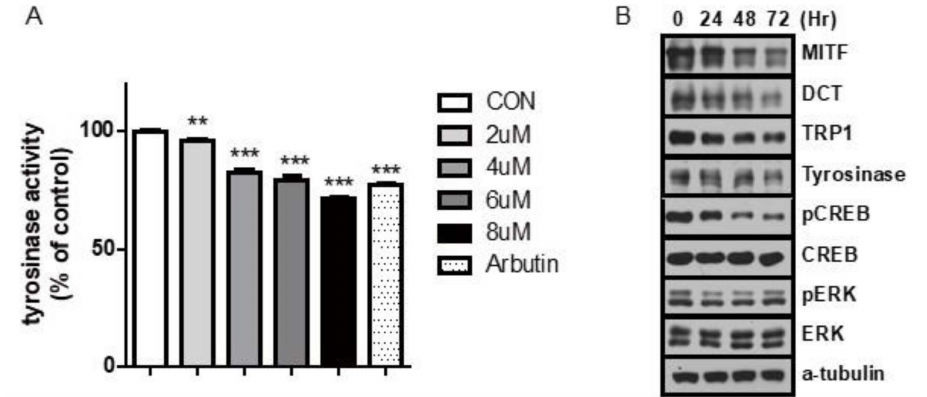
Figure 2. E ff ect of carvedilol on tyrosinase and melanogenesis-related protein expression. ( A ) E ff ect of carvedilol on tyrosinase activity when NHMs were treated with the indicated concentrations of carvedilol for 5 days. ( B ) Protein expression levels of genes associated with melanogenesis processes (MITF, DCT, TRP1, and tyrosinase) were examined using Western blotting. The assay for intracellular signaling of p-CREB and ERK revealed a decrease in p-CREB levels upon carvedilol treatment. The p-ERK level was not changed. Data are expressed as the means ± SD of three independent experiments. ** p < 0.01, *** p < 0.001 vs.